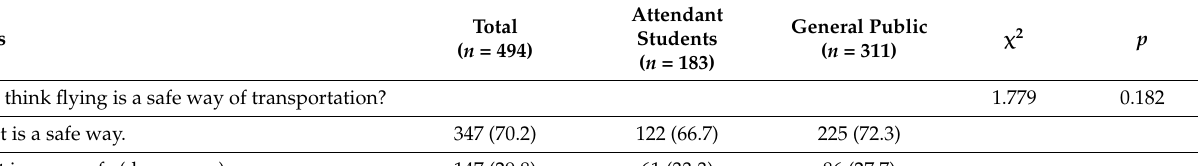
Table 3. Experiences and attitudes toward the plane crash among